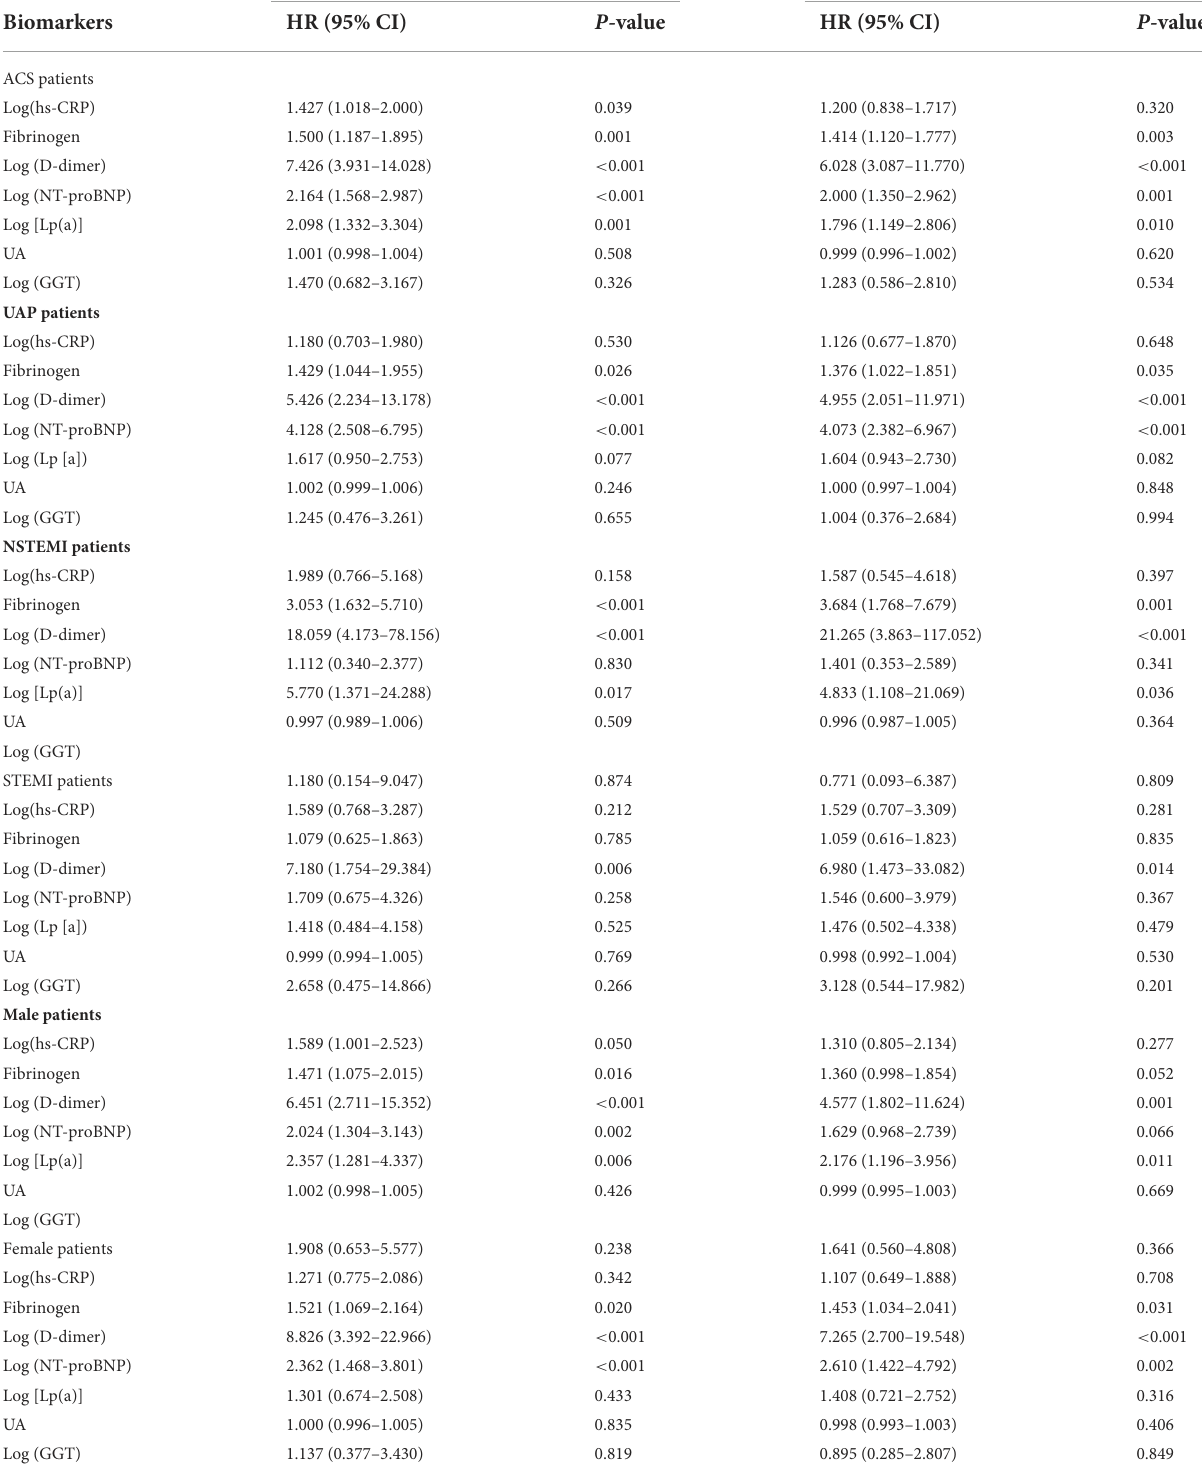
TABLE 2 Biomarkers and risk of major adverse cardiovascular event (MACE) after